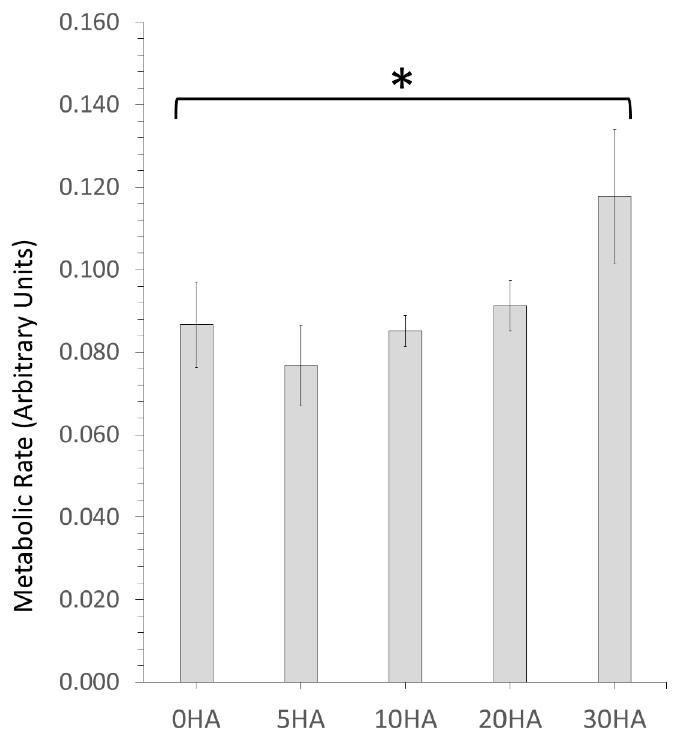
Figure 12. MTT assay results representing cell metabolic activity for U-2 OS cells adhered to the 3D printed samples and cultured under standard conditions for 7 days. Each sample type was tested in triplicate. Error bars represent standard deviation. (*— p <